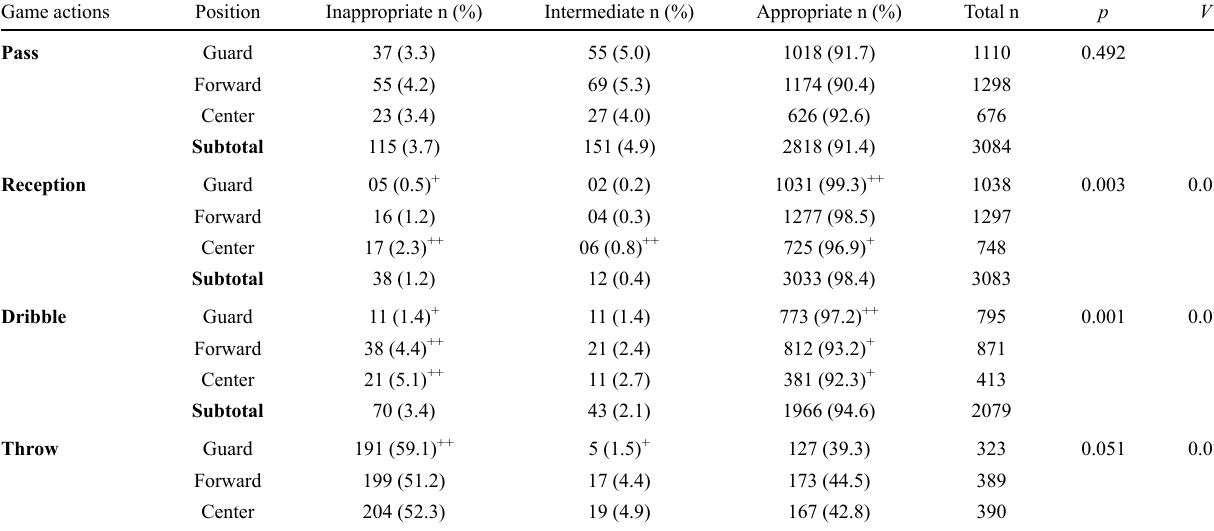
wards showed the highest percentage of inappropriate actions in the dribble and intermediate in the rebound block, while the centers presented the highest percen- tage of inappropriate actions in two actions (reception and dribble).